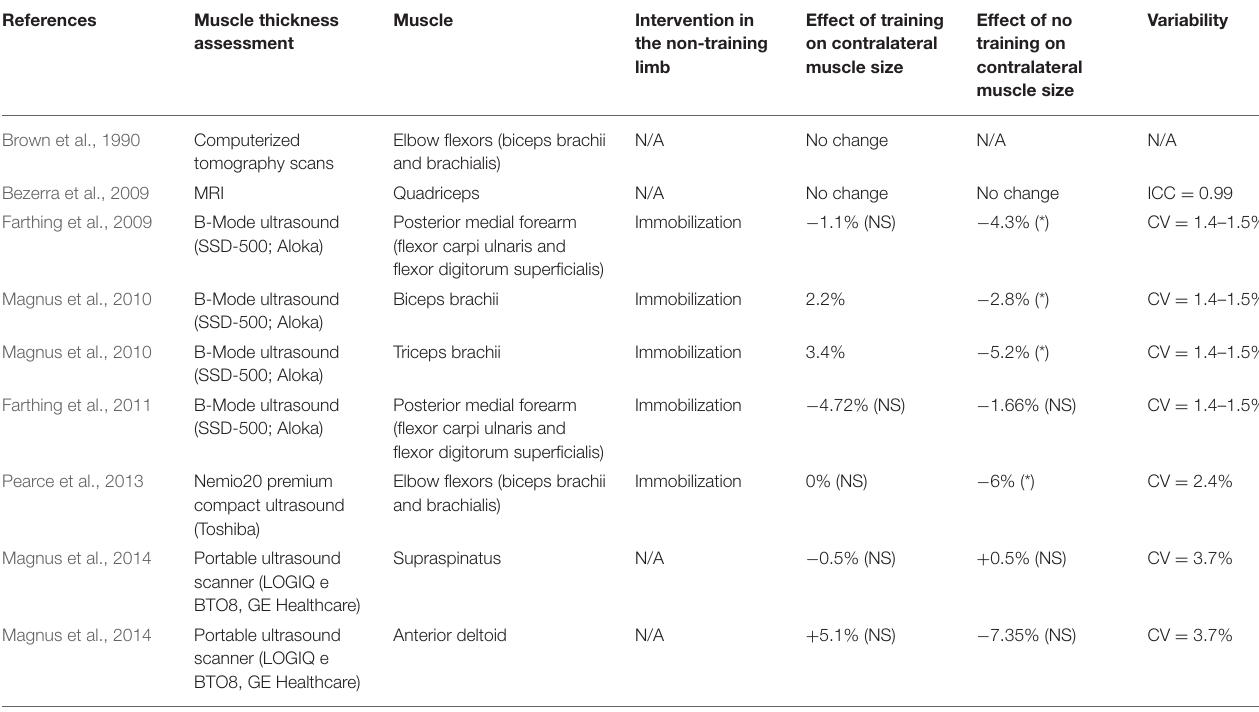
TABLE 1 | Studies reporting a change in muscle adaption with unilateral